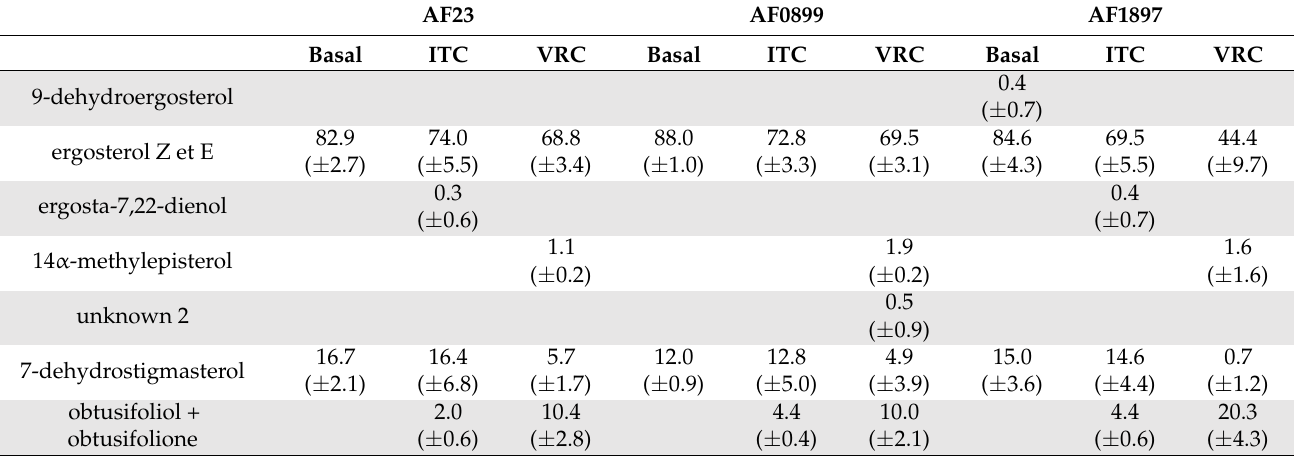
Table 4. Relative composition of sterols of group 2, strains with TR 34 /L98H alterations, under basal conditions or after in vitro exposure to itraconazole (ITC) (concentration = 32 mg/L) or voricona- zole (VRC) (concentration = 0.25 × MIC). Values are expressed as the mean of three independent experiments, standard deviation is given in